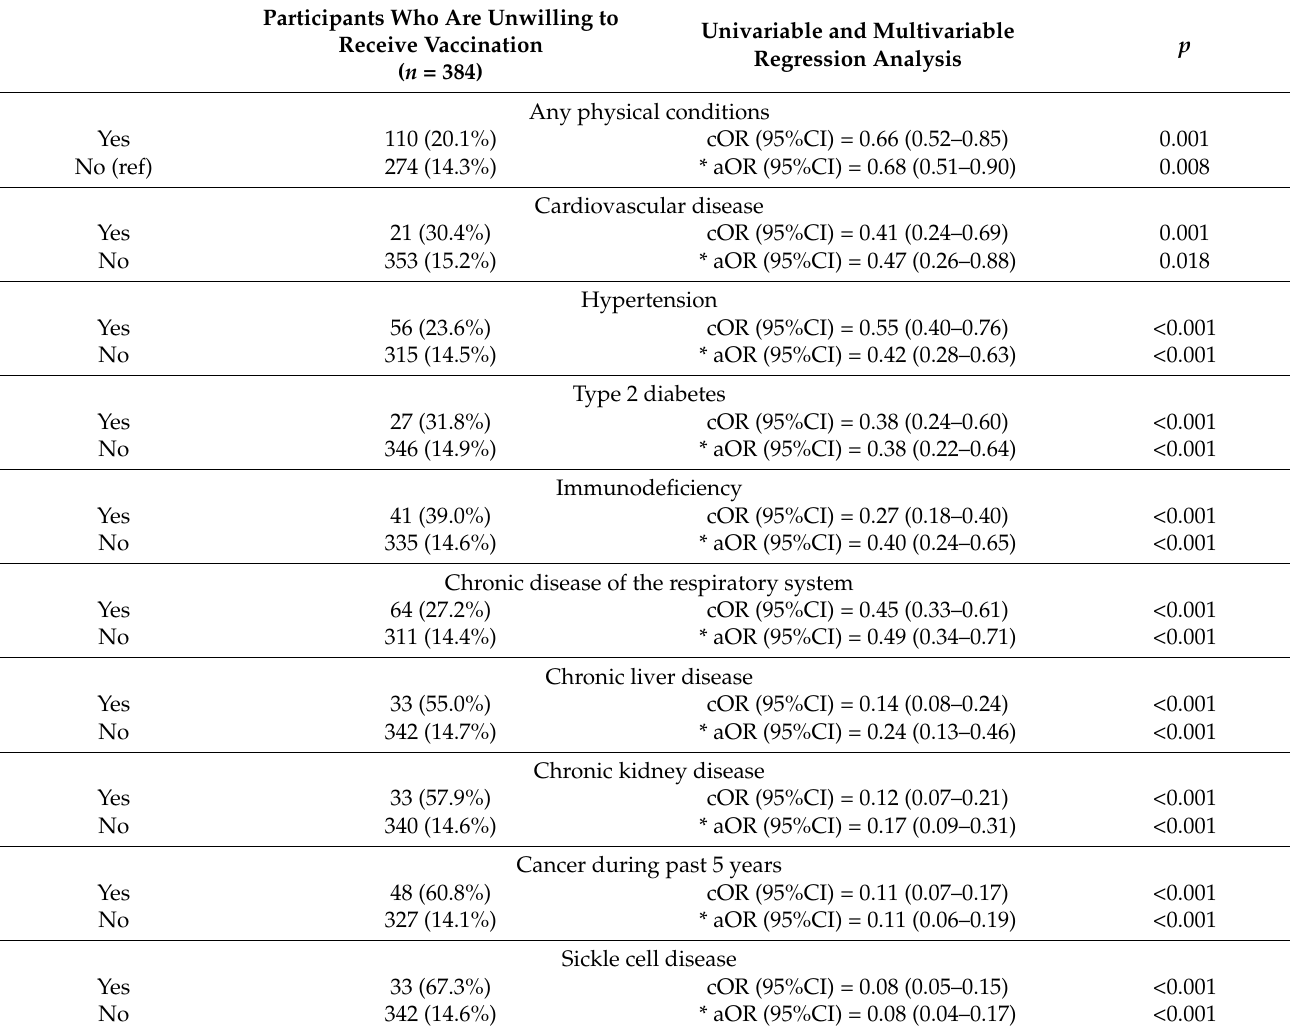
Table 3. Associations between chronic conditions and COVID-19 vaccination intention ( n =